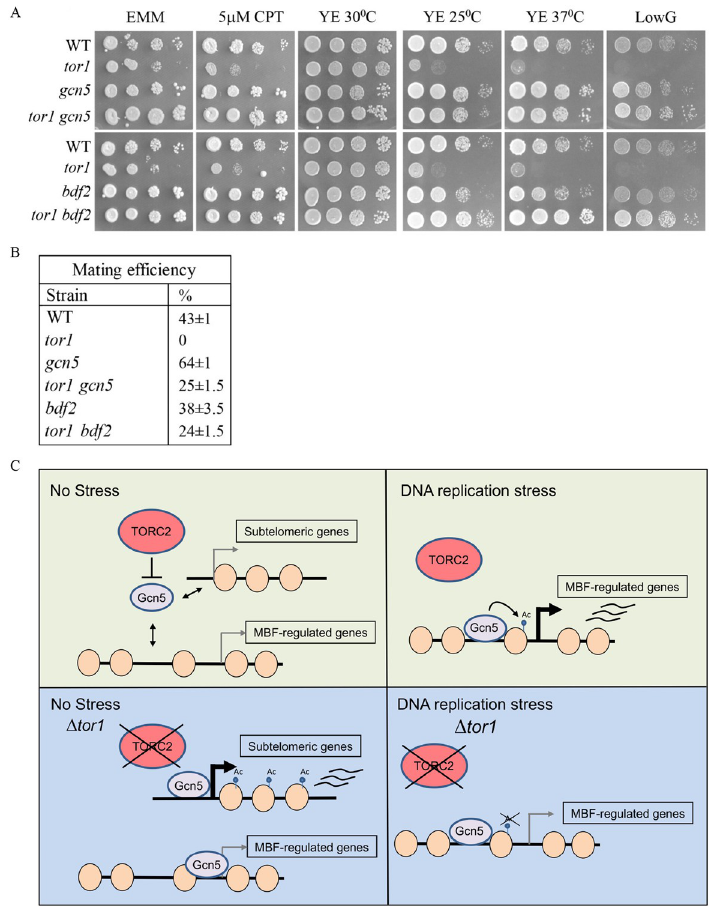
Fig 7. Loss of Gcn5 or Bdf2 suppresses the hypersensitivity and sterility of TORC2 mutant cells. ( A ) Serial dilution of exponentially growing wild type and deletion mutant cells were spotted onto minimal medium (EMM), with or without camptothecin (CPT) or onto rich medium (YE) at standard temperature (30˚C), low temperature (25˚C), high temperature (37˚C) or YE medium in which glucose was replaced with 2% galactose and 0.1% glucose (LowG). ( B ) Mating efficiency was determined on SPA plates as described in Material and Methods. The results are the mean values of three separate experiments. ( C ) A schematic illustration depicting the effects of TORC2 on Gcn5 loading and gene transcription at subtelomeric and MBF-regulated genes under normal and DNA replication